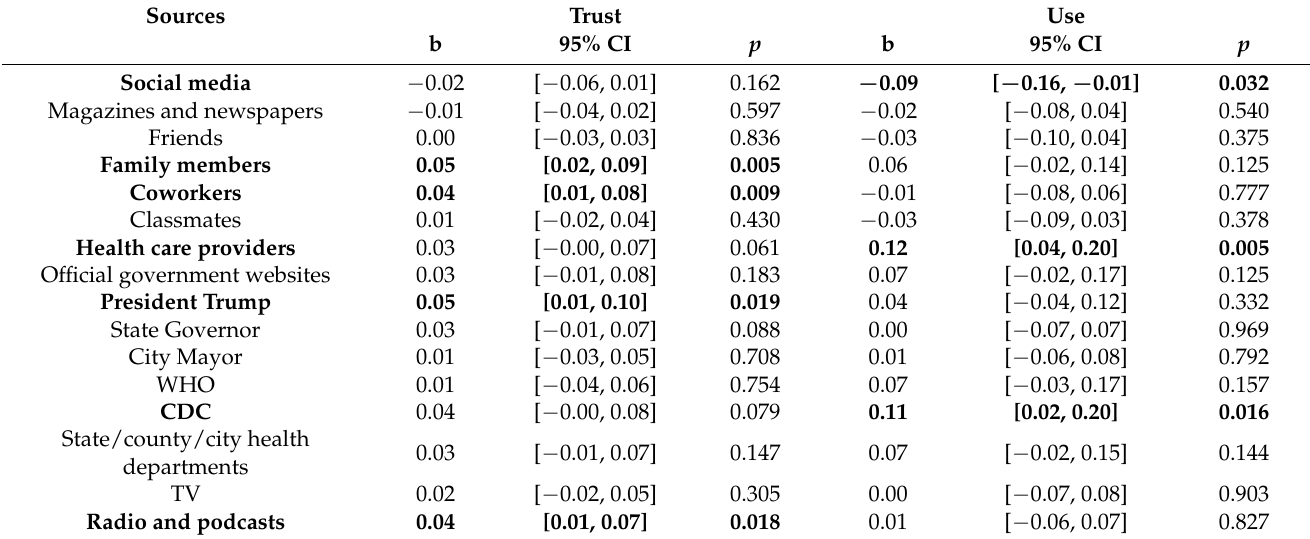
Table 3. Health literacy, and use of and trust in sources for COVID-19